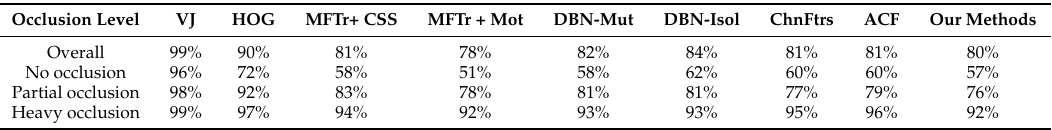
Table 1. The comparison of the miss rates between major excellent or typical methods on the Caltech dataset for the overall data and the three different occlusion level data with false positives per image (FPPI) =